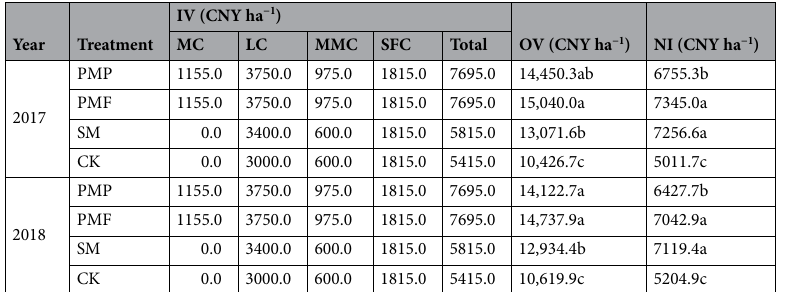
Table 5. Economic returns and net income under different cultivation practices in Hesheng County of Gansu Province, China, in 2017 and 2018. Different letters within columns indicate significant differences (P < 0.05) according to the LSD